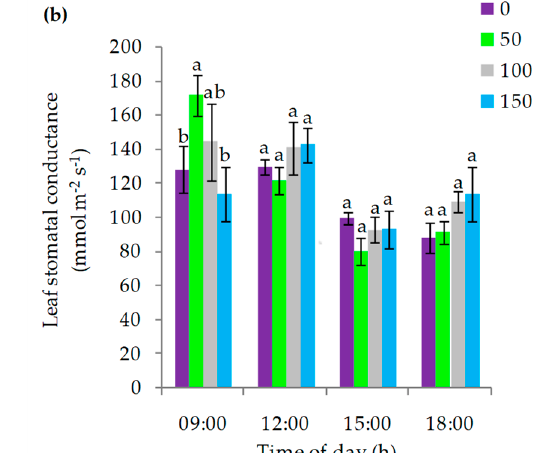
Figure 5. ( a ) Leaf area index values recorded in calafate plants; ( b ) leaf chlorophyll index recorded in calafate leaves subjected to different doses of water replenishment. Treatments: 0%, 50%, 100% and 150% ET 0. Different lowercase letters indicate significant differences between treatments according to Fischer’s LSD test ( p < 0.05). Mean ± standard error ( n = 4). Bars correspond to experimental error for each treatment.